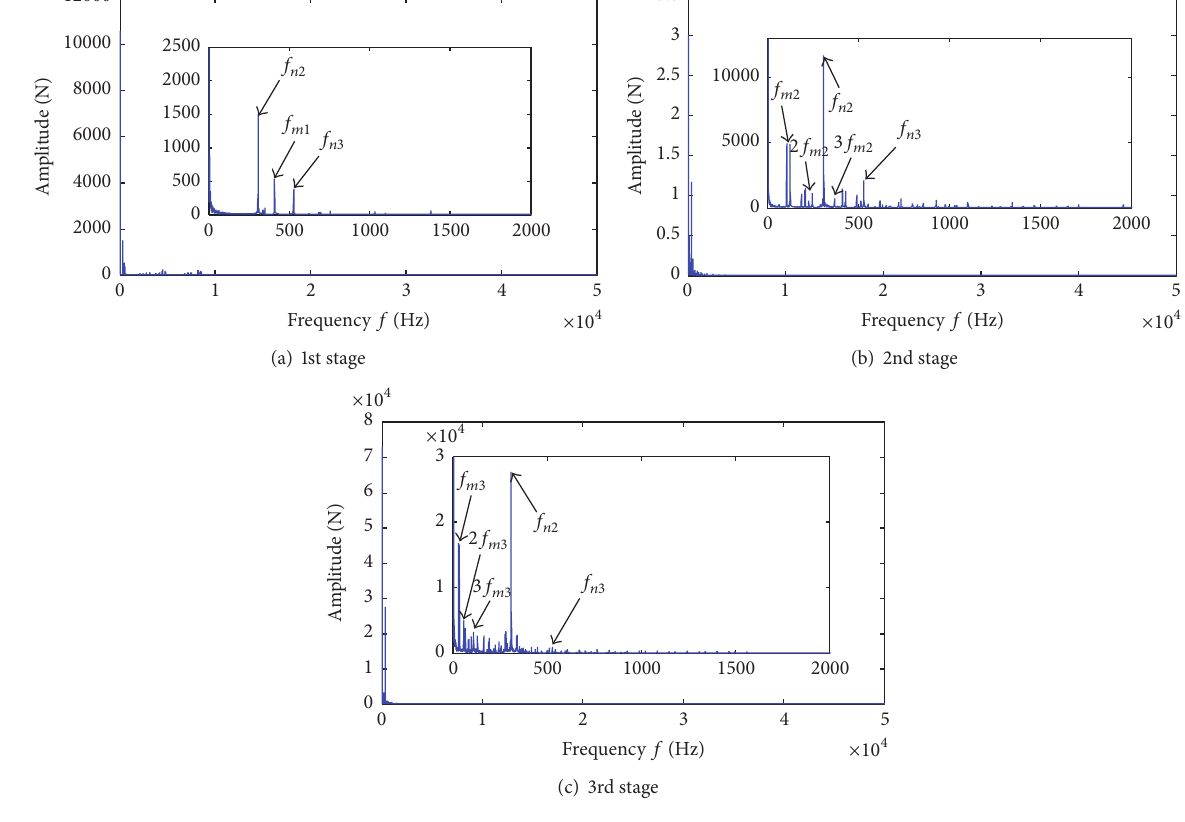
Figure 13: External meshing force in frequency domain.